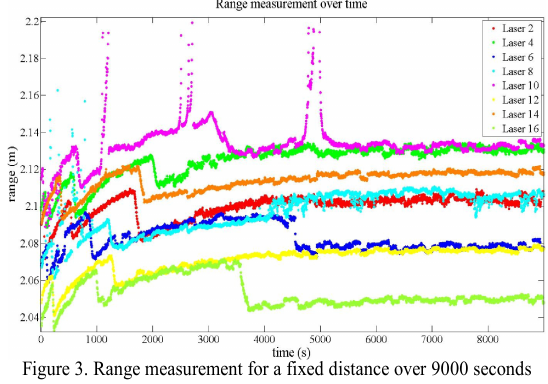
Figure 3. Range measurement for a fixed distance over 9000 seconds (Lasers: 2, 4, 6, 8, 10, 12, 14 and 16) A short subset of data (60 s) after the first 5000 s from five of